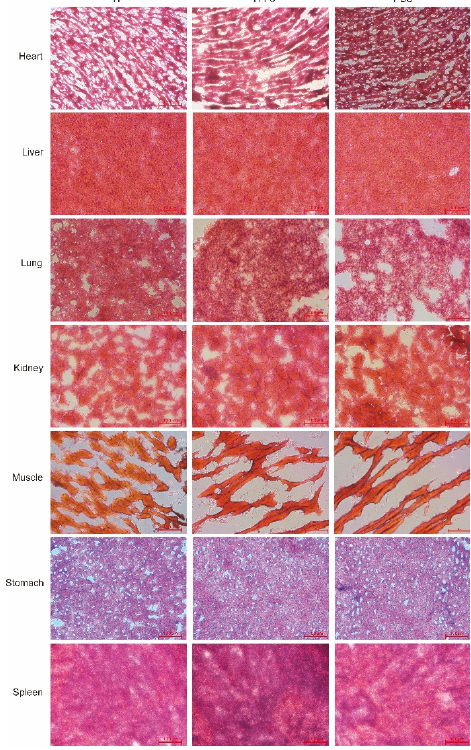
Figure 3. HE-stained sections of mice after immunization with antigens expressed in E. coli . The heart, liver, lung, kidney, muscle, stomach and spleen tissues were tested. The scale bar is 100 μ m.